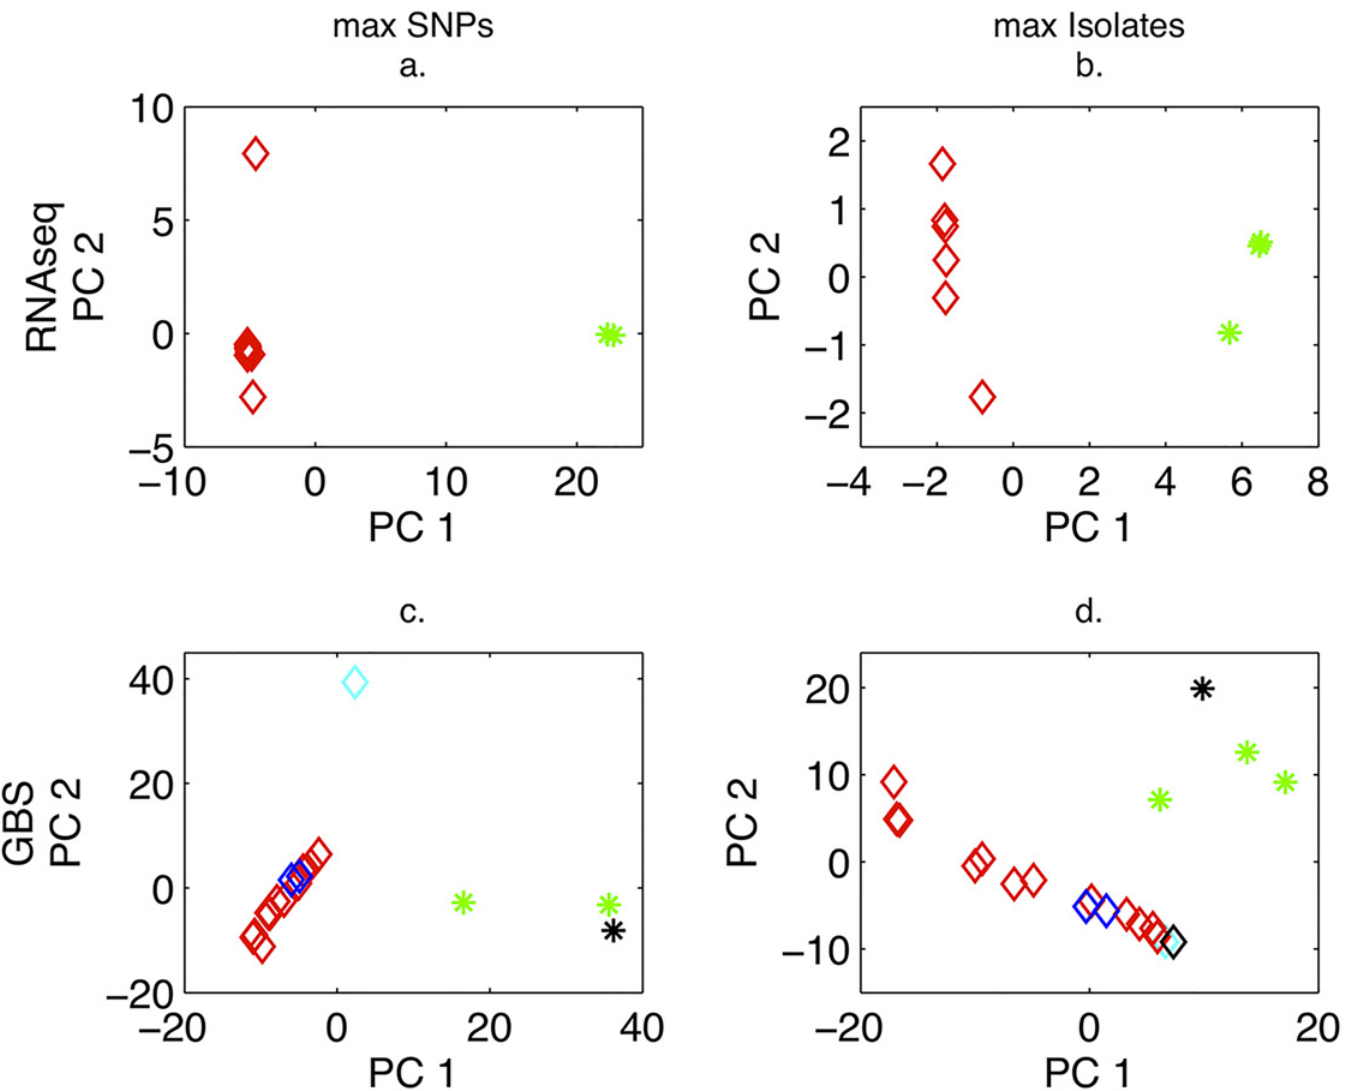
Fig 2. Principal components analysis of RNA-seq and GBS SNP data for P . cubensis isolates, maximizing for SNPs or isolates retained. a. PCA using 1,290 biallelic SNPs for P . cubensis isolates only. Red diamonds (9) represent cucumber and cantaloupe isolates and green asterisks (2) represent squash isolates. b. PCA using 135 biallelic SNPs for P . cubensis isolates only. Red diamonds (11) represent cucumber and cantaloupe isolates and green asterisks (3) represent squash isolates. c. PCA using 11,922 biallelic SNPs for P . cubensis isolates only. Red diamonds (11) represent cucumber and cantaloupe isolates from NY, and green asterisks (2) represent squash isolates from NY. The black asterisk represents CDM-SQ, a squash isolate from SC. The cyan diamond represents CAcuc2008, a cucumber isolate from CA. The two blue diamonds represent cucumber isolates from NC. d. PCA using 5,044 biallelic SNPs for P . cubensis isolates only. Red diamonds (12) represent cucumber and cantaloupe isolates from NY, and green asterisks (3) represent squash isolates from NY. The black asterisk represents a squash isolate from SC (CDM-SQ). The black diamond represents a pumpkin isolate from NC (CDM-PM). The cyan diamond represents CDM-CA, a cucumber isolate from CA. The blue diamonds (2) represent cucumber isolates from